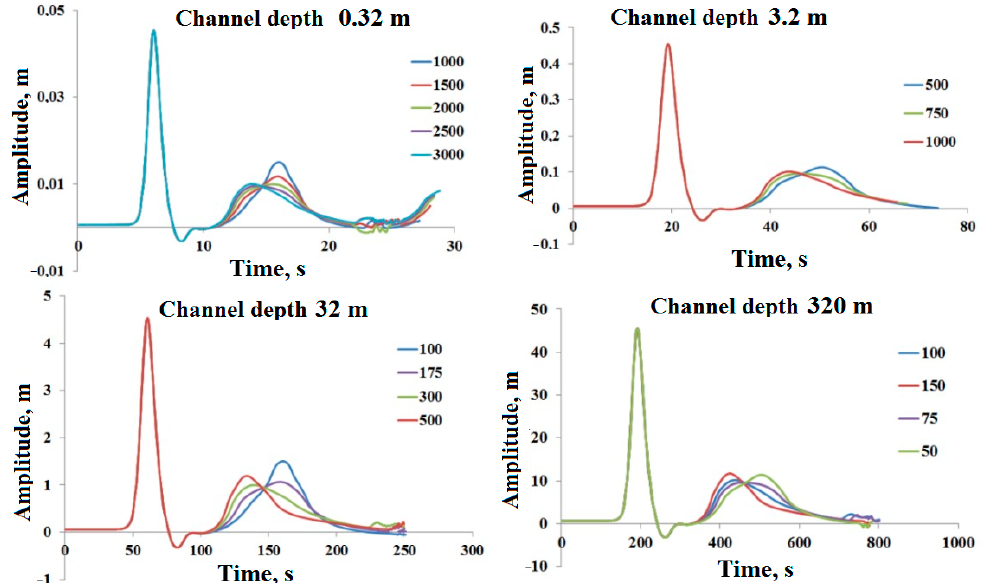
Figure 2. Tide gauge data comparing the amplitude of the reflected wave with different damping parameters for the varied channel